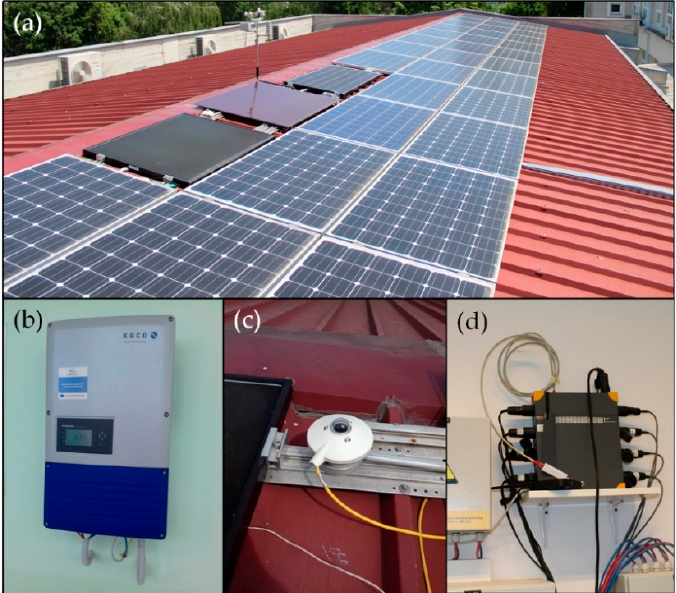
Figure 2. Equipment used to obtain measurements for our analysis: ( a ) PV plant strings; ( b ) PV plant inverter Kaco Powador 12.0 TL3; ( c ) pyranometer Kipp&Zonnen SMP3; and ( d ) power quality analyzer Fluke 1760.